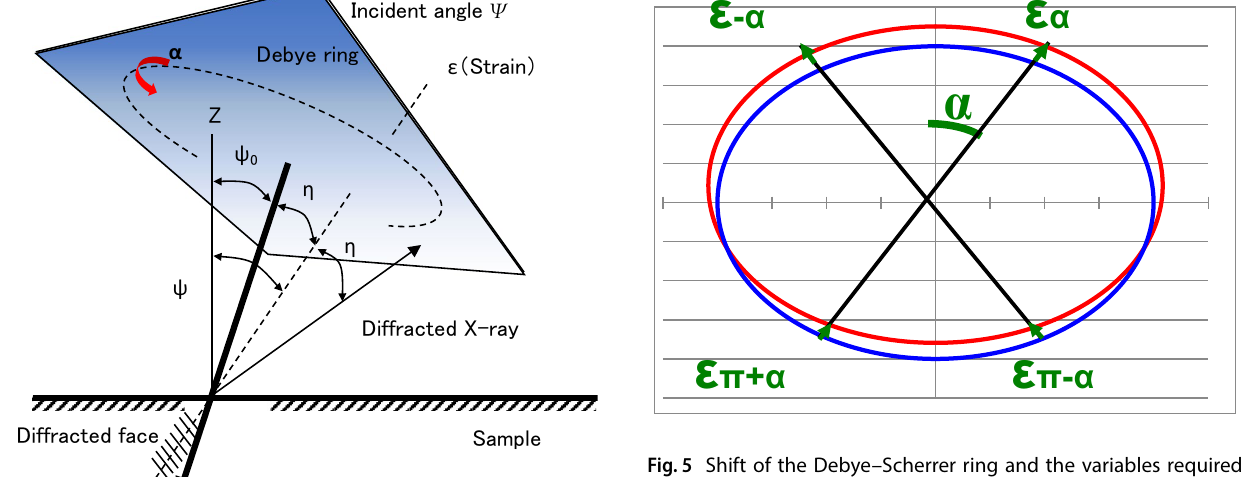
Fig. 5 Shift of the Debye–Scherrer ring and the variables required to calculate it